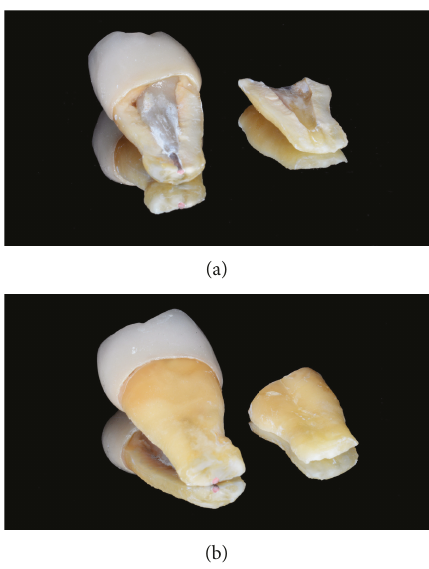
Figure 10: Inner (a) and outer (b) views of the two fragments produced by the longitudinal fracture, retrieved after tooth extraction.